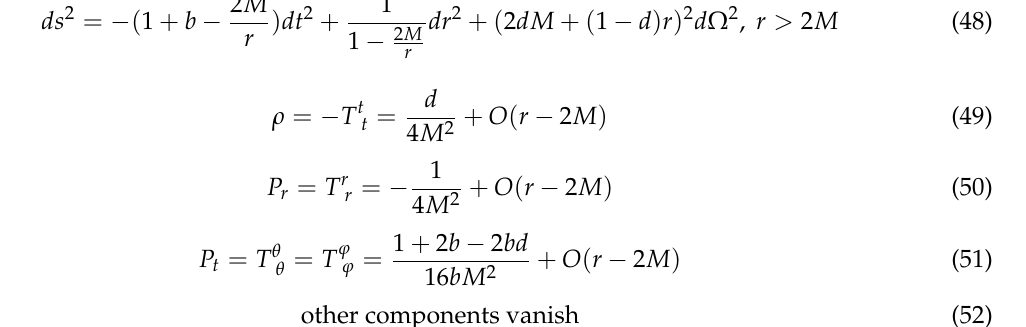
Figure 5. Anisotropic behavior of pressure of Schwarzschild mock fuzzball versus proper distance from horizon. The absolute value of two pressures are equal at r = 3 M is much larger than tangential (solid line) pressure near horizon (proper length = 0), while the trend reverses far away. The figure shows that when approaching horizon, both pressures reach their maxima, hence have no singularity at r =